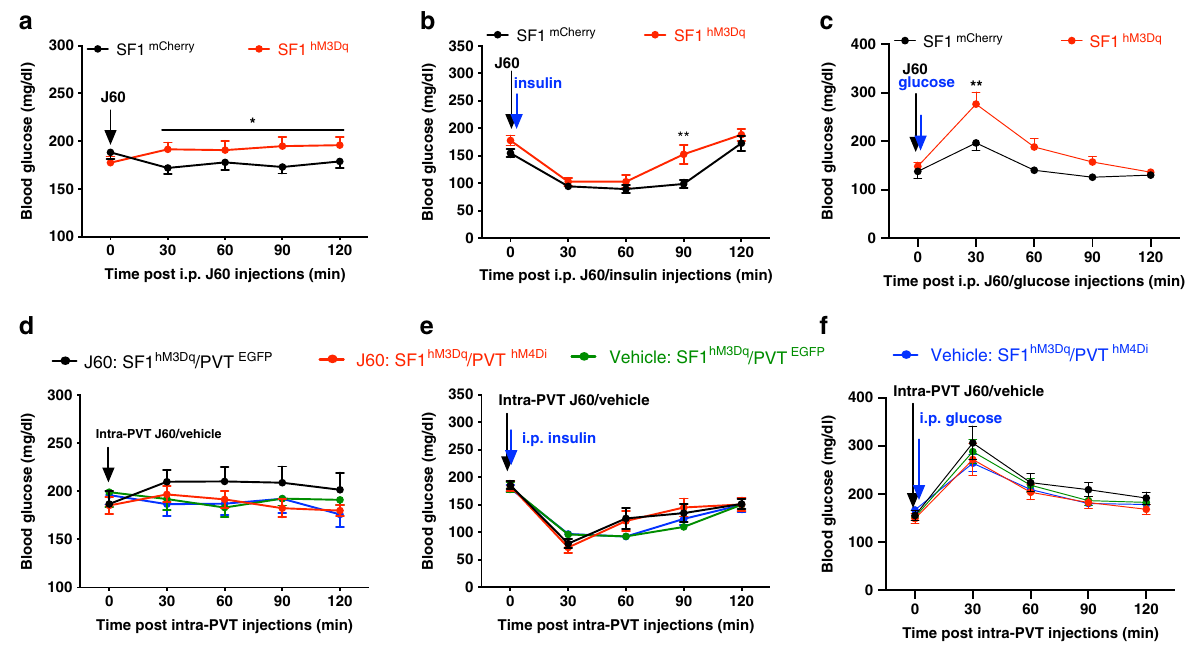
Fig. 9 Activation of SF1 neurons increases blood glucose and impairs ITT and GTT. a – c DREADD activation of SF1 neurons with J60 via i.p. injections a increased basal glucose level in SF1 hM3Dq-tranduced mice ( n = 7 males and 8 females) as compared to mCherry-transduced mice ( n = 7 males and 7 females, p = 0.0166), b impaired ITT (hM3Dq, n = 6; mCherry, n = 7; p = 0.0024) and c GTT (hM3Dq, n = 8; mCherry, n = 6; p = 0.0011). d – f J60 or vehicle was administered via intra-PVT injections in mice transduced with hM3Dq in SF1 neurons and hM4Di or control EGFP in PVT neurons. d Basal glucose level (SF1 hM3Dq/PVT EGFP, n = 6 for J60 and n = 5 for vehicle; SF1 hM3Dq/PVT hM4Di, n = 7 for J60 and n = 5 for vehicle). e ITT (SF1 hM3Dq/ PVT EGFP, n = 6 for J60 and n = 6 for vehicle; SF1 hM3Dq/PVT hM4Di, n = 7 for J60 and n = 7 for vehicle). f GTT (SF1 hM3Dq/PVT EGFP, n = 6 for J60, n = 6 for vehicle; SF1 hM3Dq/PVT hM4Di, n = 7 for J60, n = 7 for vehicle). Two-way ANOVA with Sidak post hoc tests were performed. Data represent mean ± s.e.m. * p < 0.05; ** p <